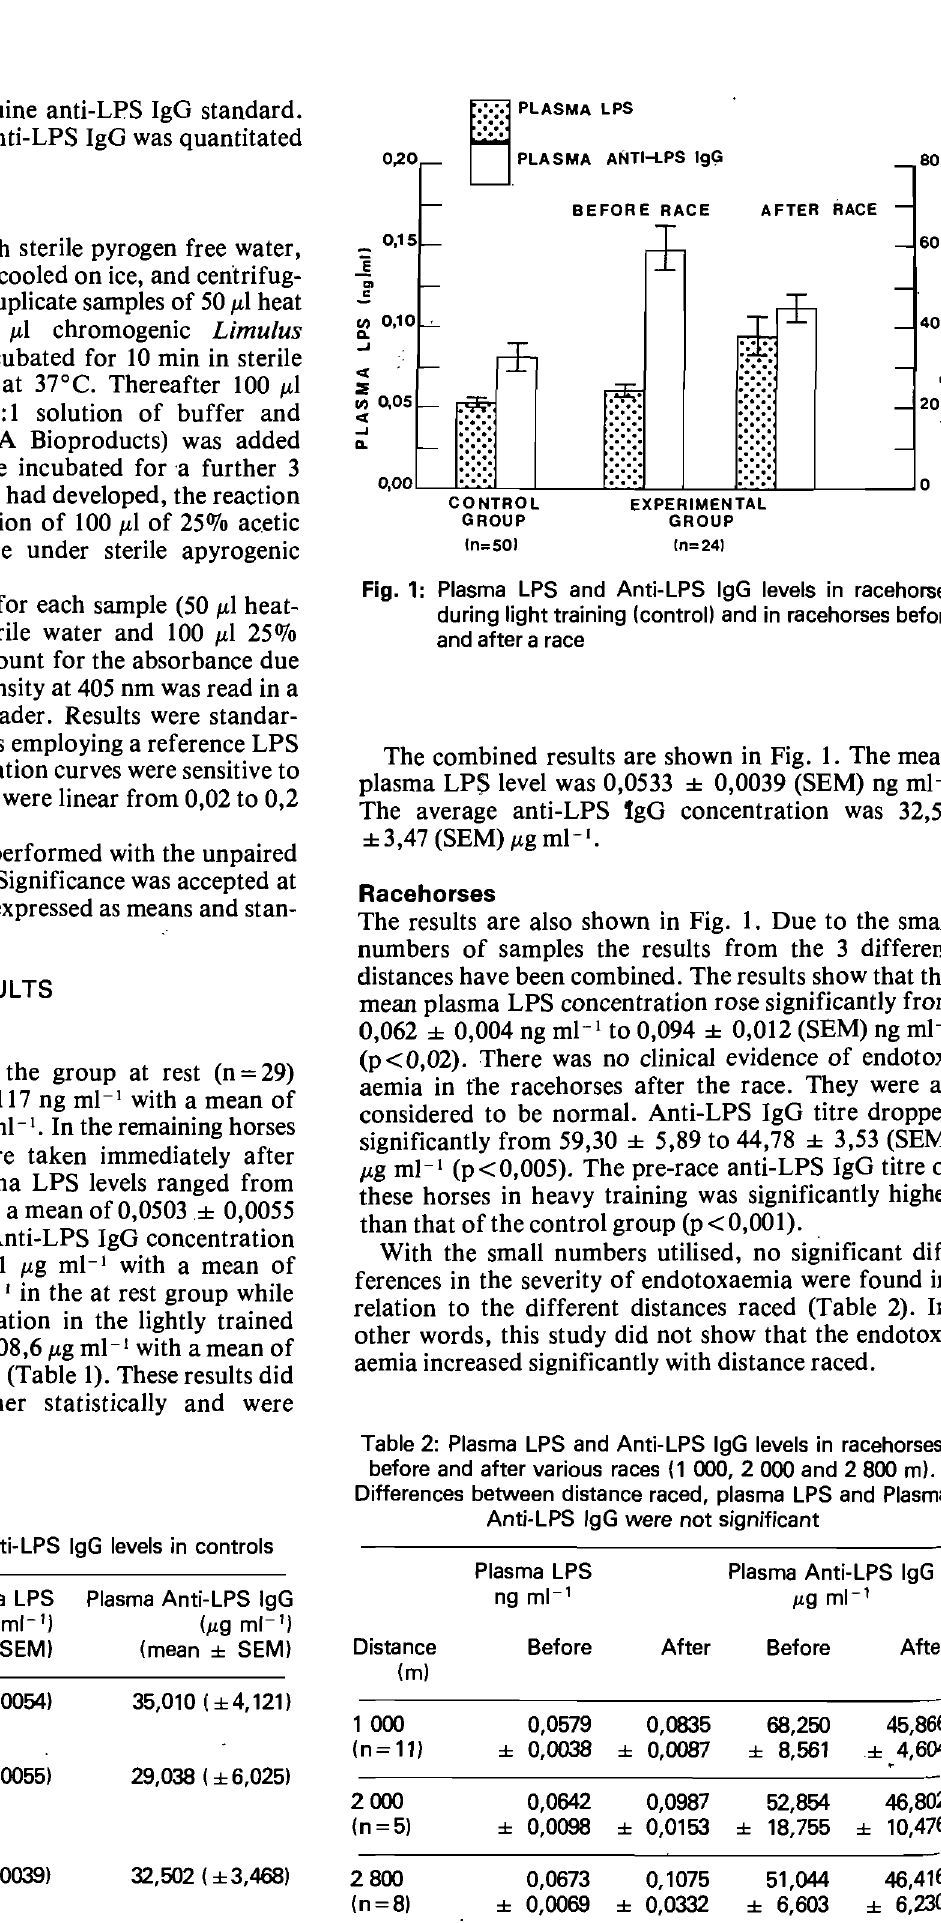
Table 1: Plasma LPS and Anti-LPS IgG levels in controls Group